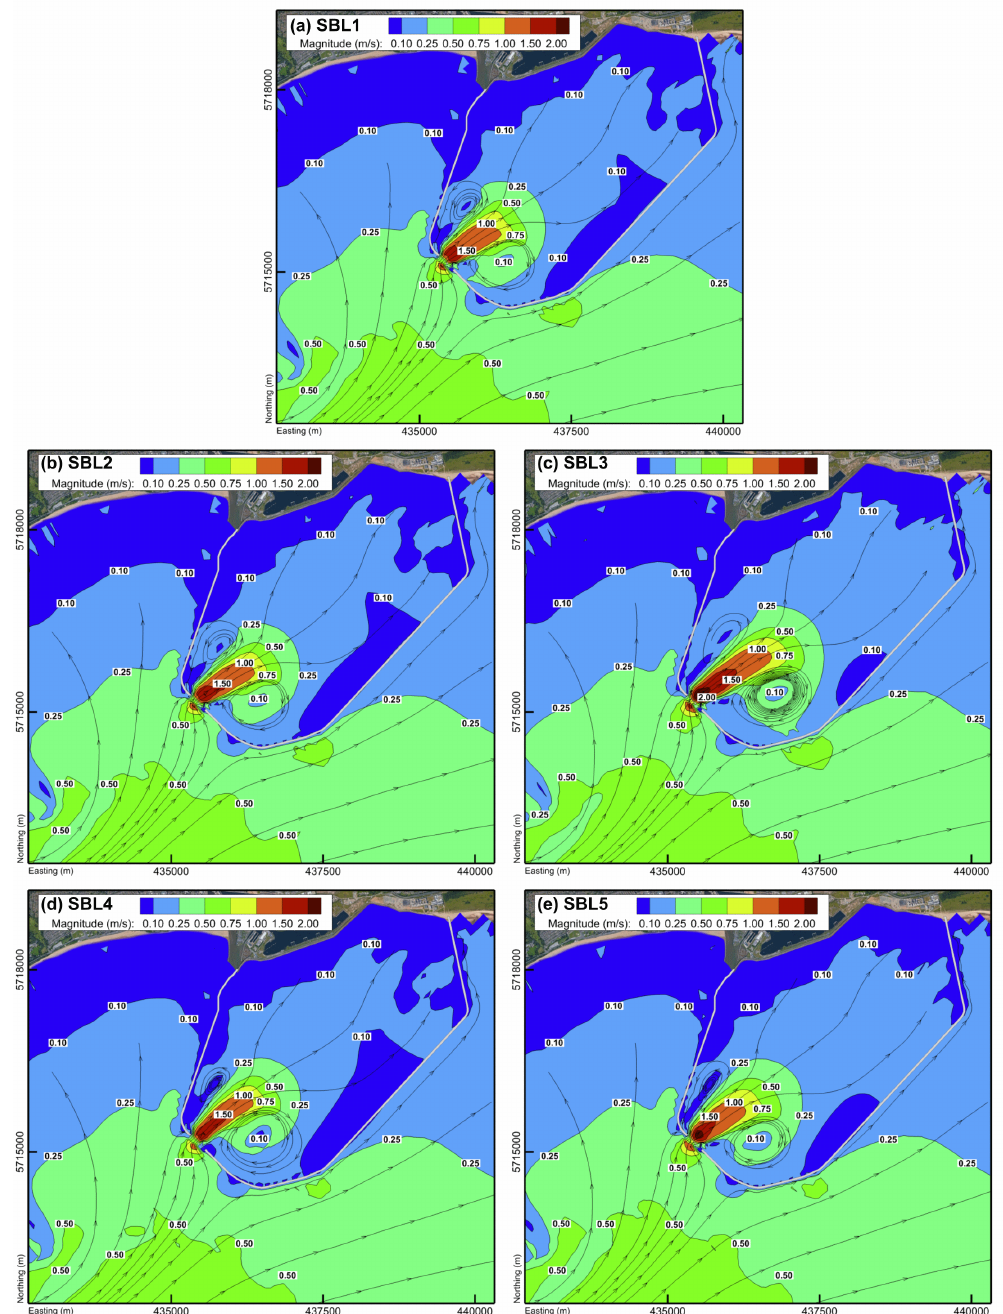
Figure 12. A comparison of velocity fields during the flood generation phase for a typical spring tidal cycle. ( a ) 2D simulation with no refinements (SBL1); ( b ) 2D with A T 1 = 216.1 m 2 (SBL2); ( c ) 2D with A T 2 = 38.5 m 2 (SBL3); ( d ) 3D with A T 1 = 216.1 m 2 (SBL4); ( e ) 2D with A T 2 = 38.5 m 2